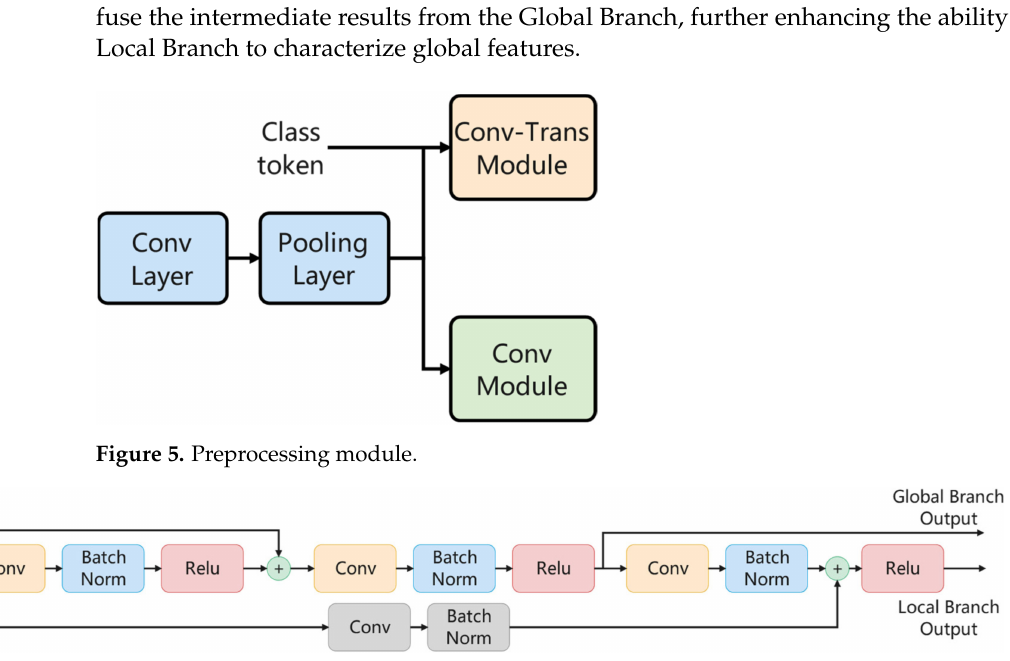
Figure 6. Convolution module in the Local